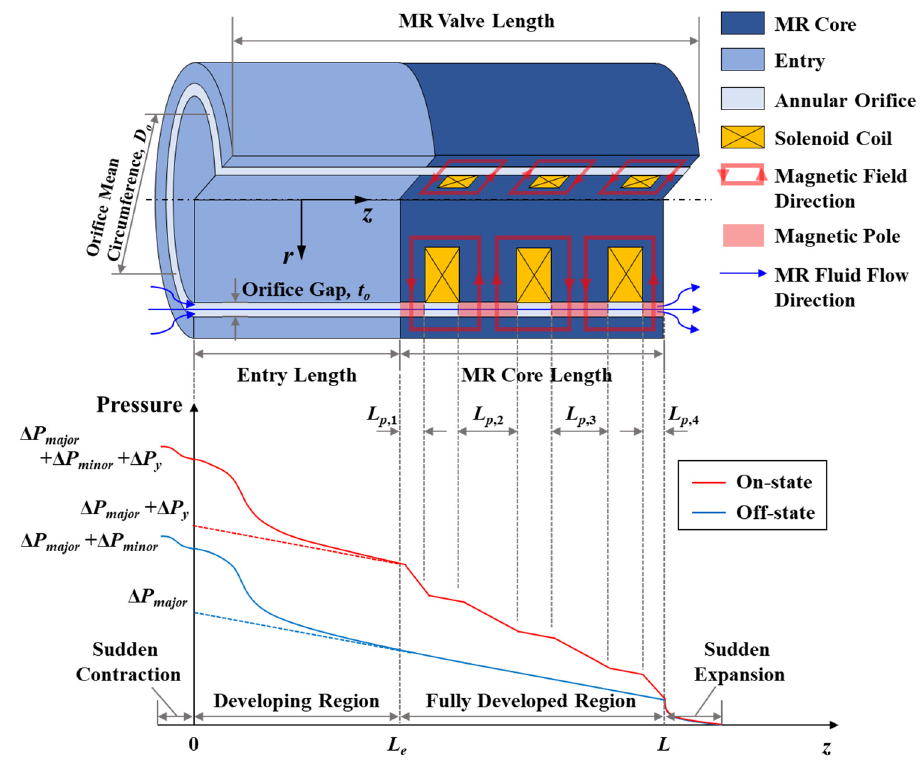
Figure 3. MR valve configuration and pressure drop in the annular orifice under compression con- dition.